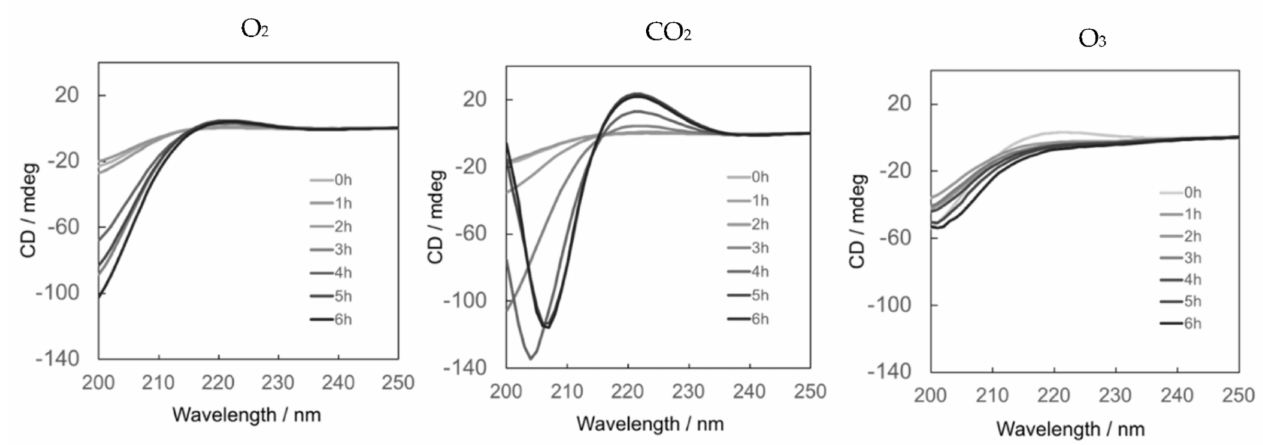
Figure 4. Changes in the circular dichroism (CD) spectral pattern of the collagen solution extracted with 0.1 M acetic acid over the course of 6 h when supplying ultrafine bubbles of each gas